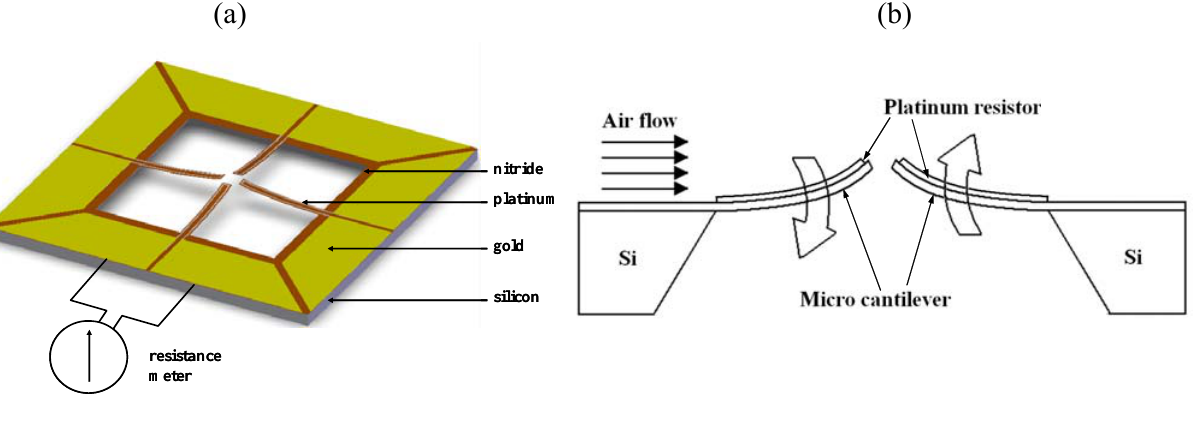
Figure 2. Schematic illustration showing deflection of microcantilevers as air flows over their surfaces. (a) Gas flow direction sensor comprising four microcantilevers arranged in cross-form configuration; (b) deflection of microcantilevers as air flows over the sensor